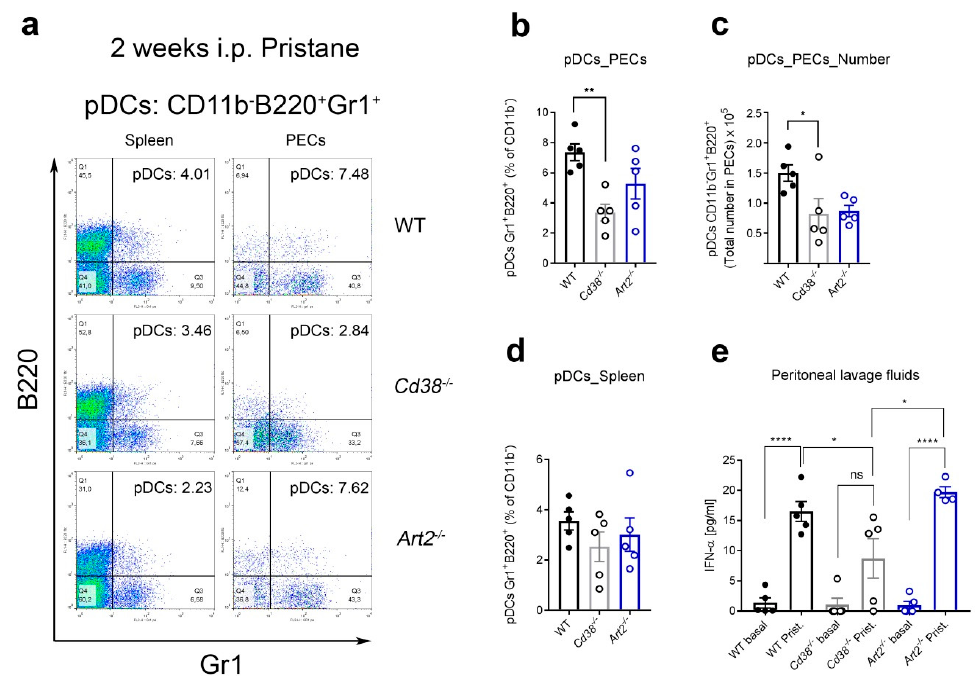
Figure 4. Decreased percentages of plasmacytoid dendritic cells (pDCs) and diminished IFN- α secretion in peritoneal lavage fluids of pristane-treated Cd38 − / − mice. ( a ) Two weeks after pristane i.p. injection, spleen cells and peritoneal exudate cells (PECs) from WT, Cd38 − / − , and Art2 − / − mice were stained with anti-B220-FITC, anti-CD11b-APC, anti-Gr1-PE, and anti-CD5-PerCP mAbs. After gating the CD11b − cells, pseudocolor-plots of B220-FITC vs. Gr1-PE are shown. Gating strategies for PECs pDCs and spleen pDCs are shown in Figures S2 and S3, respectively. In Q2, percentages of pDCs are